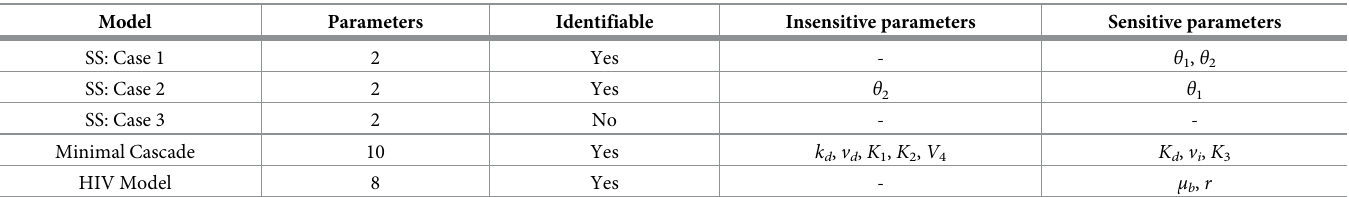
Table 4. Summary of model features analyzed in this